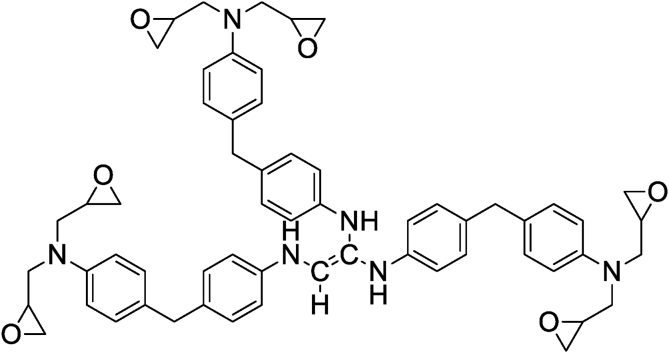
Structure of HGEMDA [42].